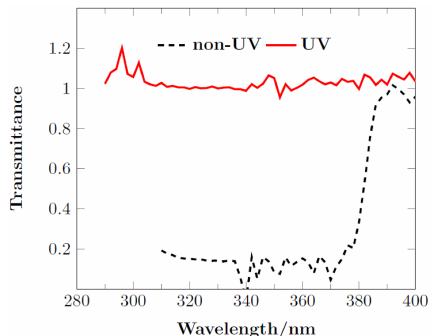
Figure 1. Transmittance as measured for the control and the UV plates. The UV plate transmits solar UV above 290nm, whereas the control plate has a cutoff at ca. 375nm (note that the control plate has an average transmittance of 15% below 375nm). As transmis- sion was measured as the ratio between solar light below plexiglass plate to light above the plexiglass plate, light reflected back by the snow might lead to transmittance greater than